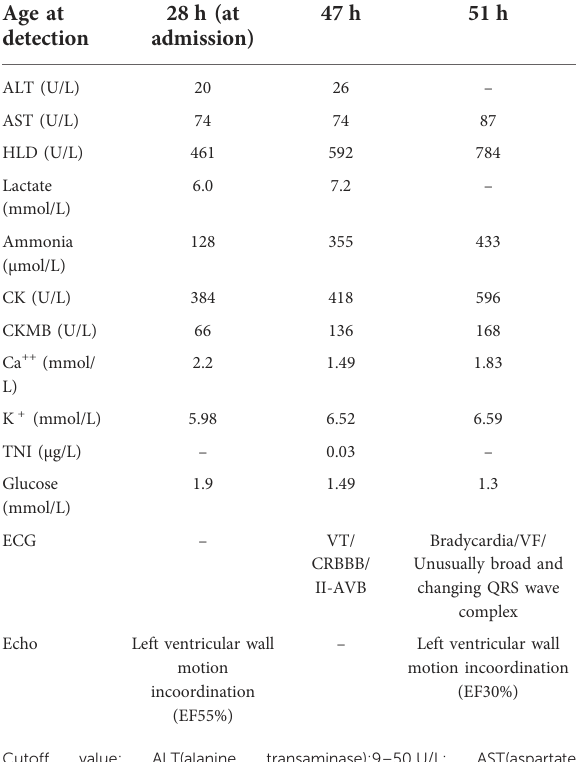
TABLE 1 Summary of the patient with CACT de fi ciency biochemistry, ECG and Echo Age at